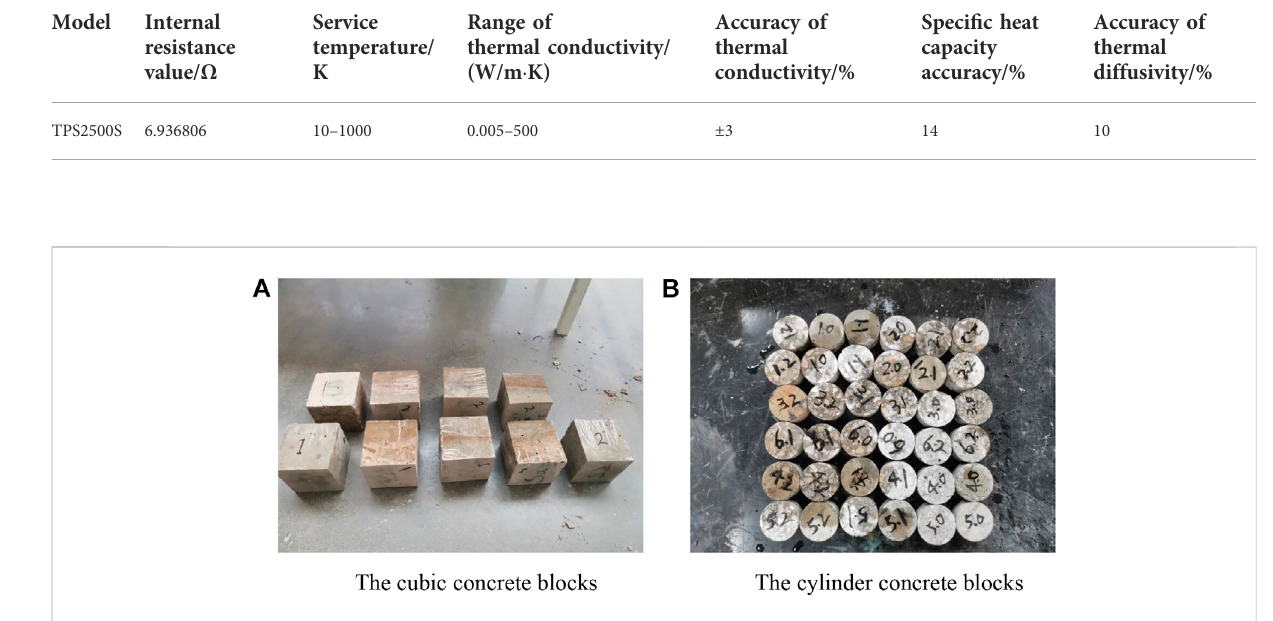
FIGURE 3 Experimental concrete blocks. (A) The cubic concrete blocks, (B) The cylinder concrete